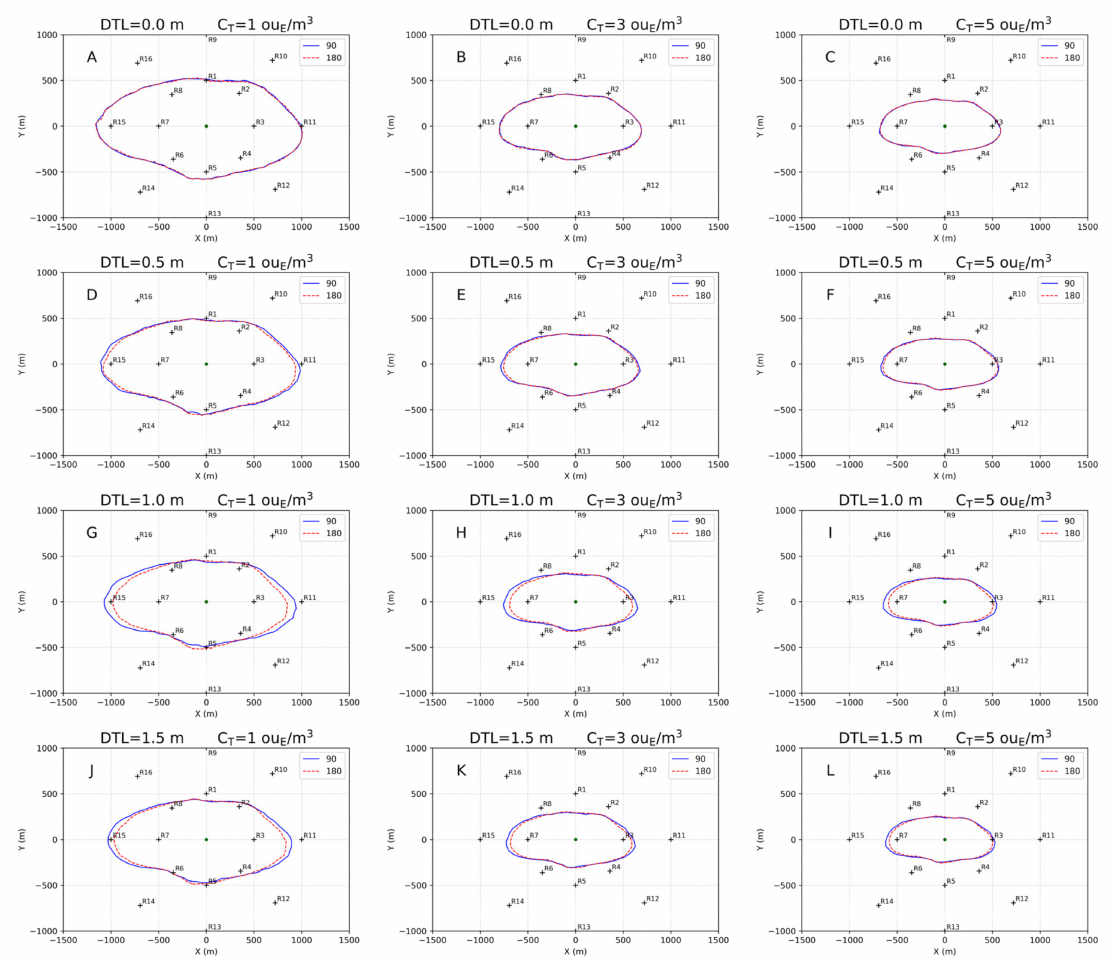
Figure 12. Tank L15_W6. Separation distances calculated for the base case (top row) and as a function of the tank orientation and DTL of 0.5 m (second row), 1.0 m (third row) and 1.5 m (bottom row). Concentration thresholds are 1 ouE/m 3 (left column), 3 ouE/m 3 (central column) and 5 ouE/m 3 (right column). The dark green circle represents the centroid of the sources, while the black crosses represent the discrete receptors. ( A ): DTL = 0.0 m, C T = 1 ouE/m 3 . ( B ): DTL = 0.0 m, C T = 3 ouE/m 3 . ( C ): DTL = 0.0 m, C T = 5 ouE/m 3 . ( D ): DTL = 0.5 m, C T = 1 ouE/m 3 . ( E ): DTL = 0.5 m, C T = 3 ouE/m 3